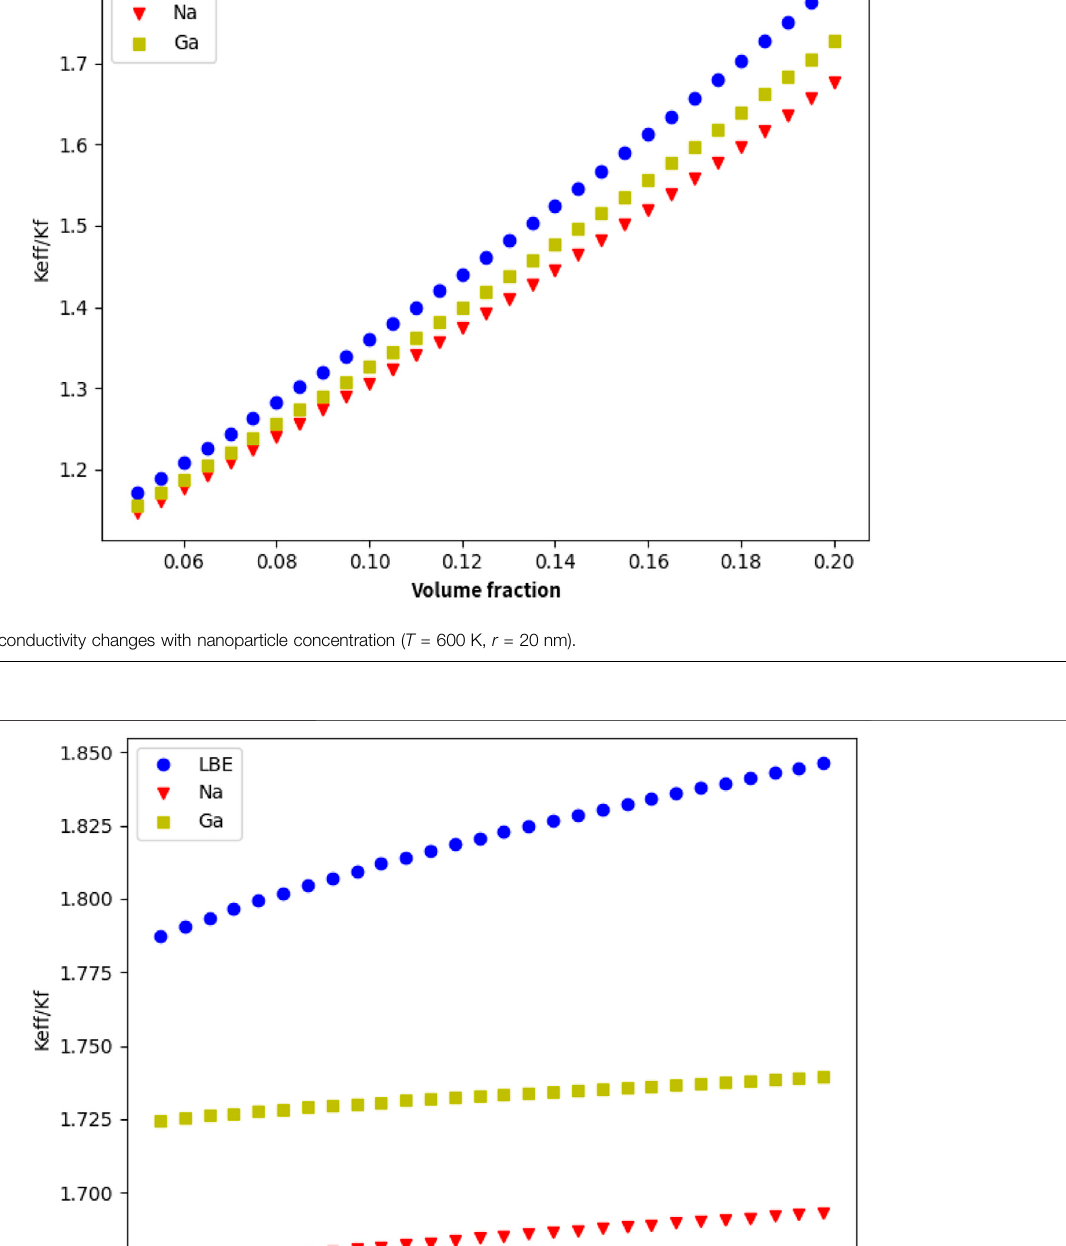
Frontiers in Energy Research |